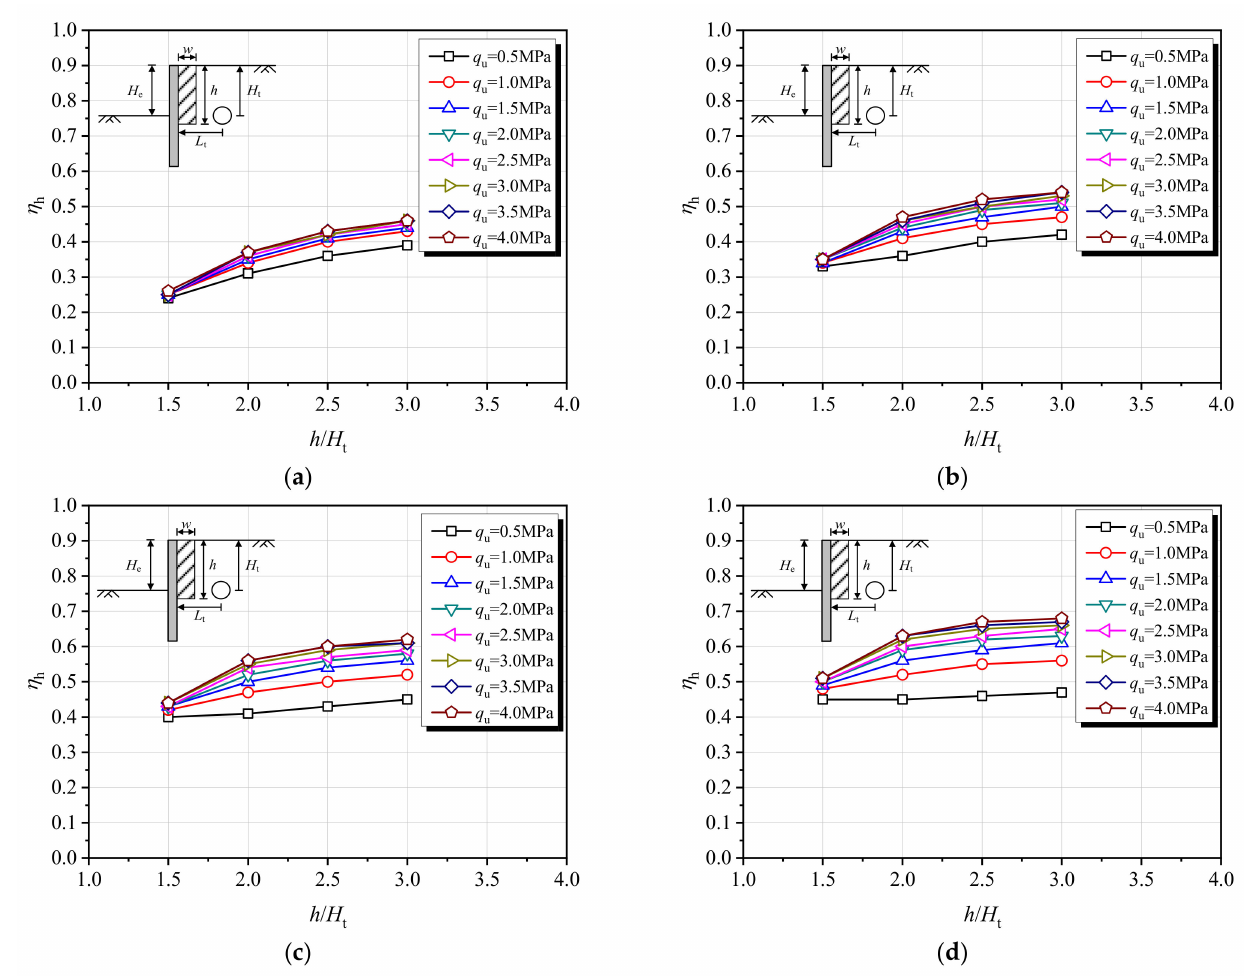
Figure 11. Evolution curves of η h with h : ( a ) w = L t /6; ( b ) w = L t /3; ( c ) w = L t /2; ( d ) w = 2 L t /3.